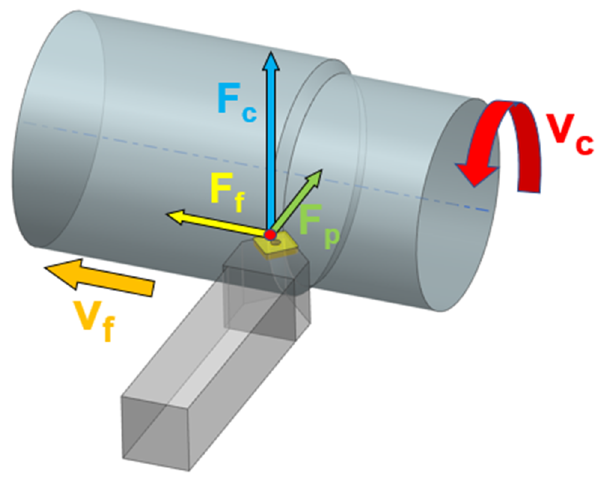
Figure 1. Force decomposition in longitudinal turning.